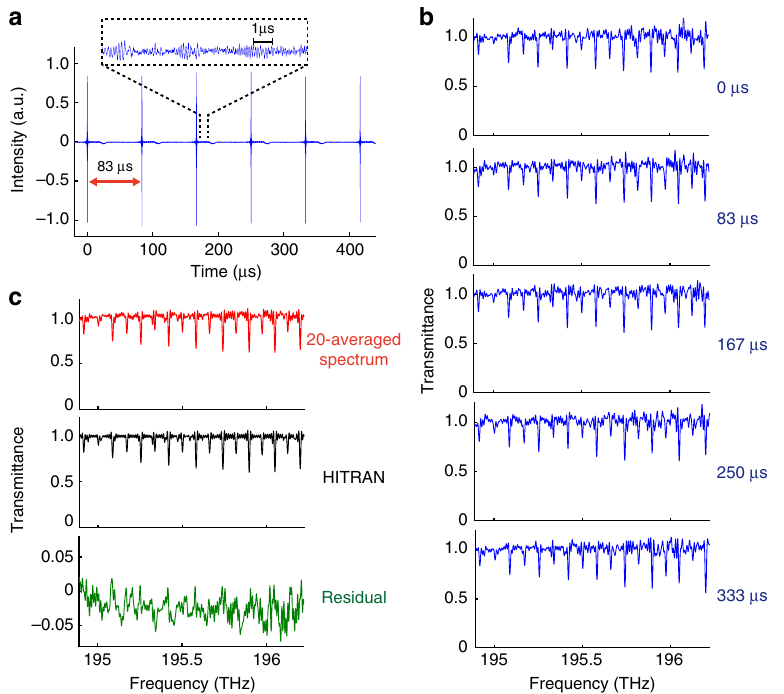
Fig. 5 High-scan-rate broadband spectroscopic measurement by PC-FTS based on a polygonal scanner. a Continuous interferograms of 12 C 2 H 2 molecules measured with the mode-locked laser. The burst of the interferogram appears every 83 µ s, corresponding to a scan rate of 12 kHz. Clear modulations of the molecular free-induction decay are observed. b Non-averaged transmission spectra corresponding to the interferograms shown in Fig. 5a. Each spectrum covers over 1.5 THz with a resolution of 11.5 GHz. The absorption lines of C 2 H 2 are clearly observed. The noise in the spectra can mainly be attributed to the side-modulations of the sinc function caused by the rectangular Fourier-transform windowing. Apodization (not applied here) can reduce the side- modulations at the expense of the spectral resolution. c Comparison between a 20-averaged transmission spectrum and a computationally calculated spectrum based on HITRAN database. The standard deviation of the residual is 1.7%